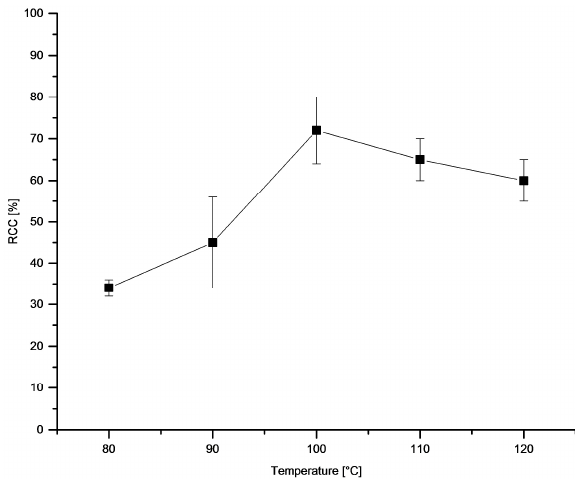
Figure 7. Dependency of RCC on temperature. Conditions: [ 18 F]Fluoride (~50 MBq) was eluted from a QMA-CO 3 cartridge with a solution of Et 4 NOTf (3.1 mg, 11 µmol) in n BuOH (300 µL) (see legend of